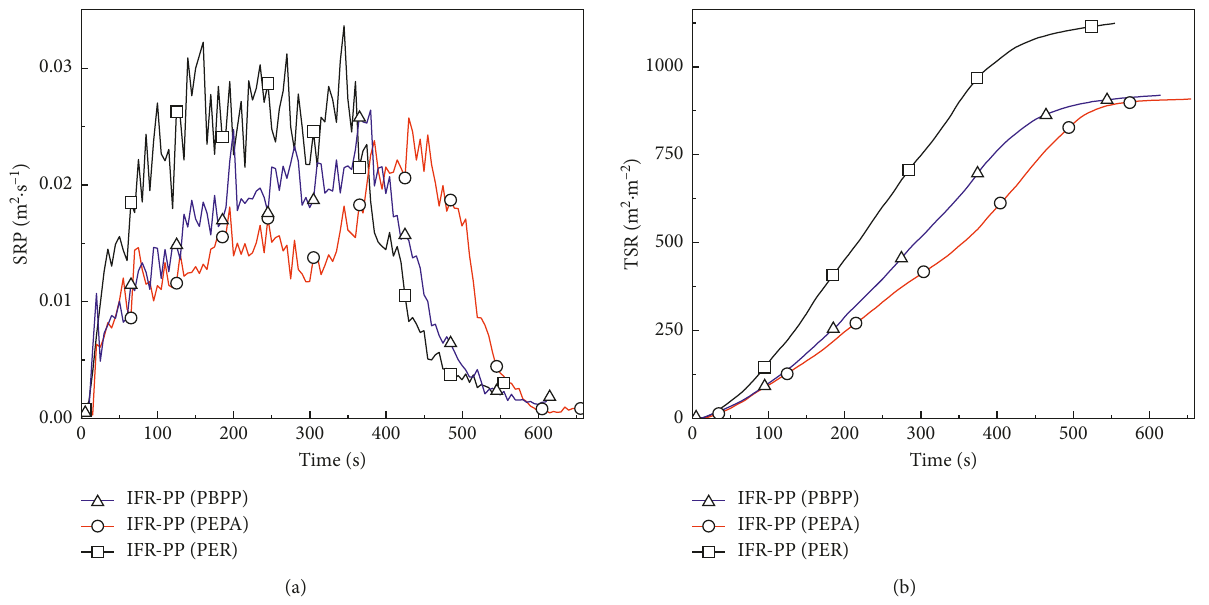
Figure 10: The SPR (a) and TSR (b) curves of IFR-PP (PER), IFR-PP (PEPA), and IFR-PP